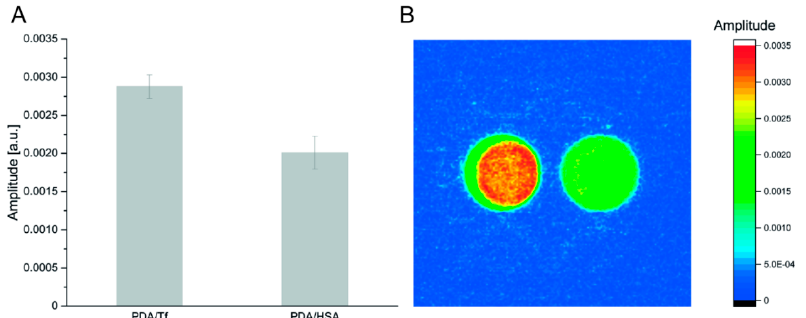
Figure 2. Comparison of the heat dissipation of the PDA/TF and the PDA/HSA, at 100 µ g/mL ( A ). 2D amplitude heat map of the same measurement, recorded with lock-in thermography (LIT) (PDA/Tf left, PDA/HSA right) ( B ). A higher amplitude signal corresponds to a more intense heat generation. N = 5.